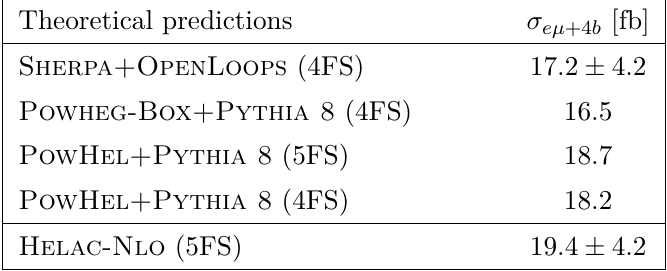
Table 4 . Predicted fiducial cross section results for the pp → t ¯ tb ¯ b process in the eµ top quark √ decay channel at the LHC with s = 13 TeV. Results for the case of at least four b -jets in the final state are shown. Except from the Helac-Nlo case all results are taken from ref.